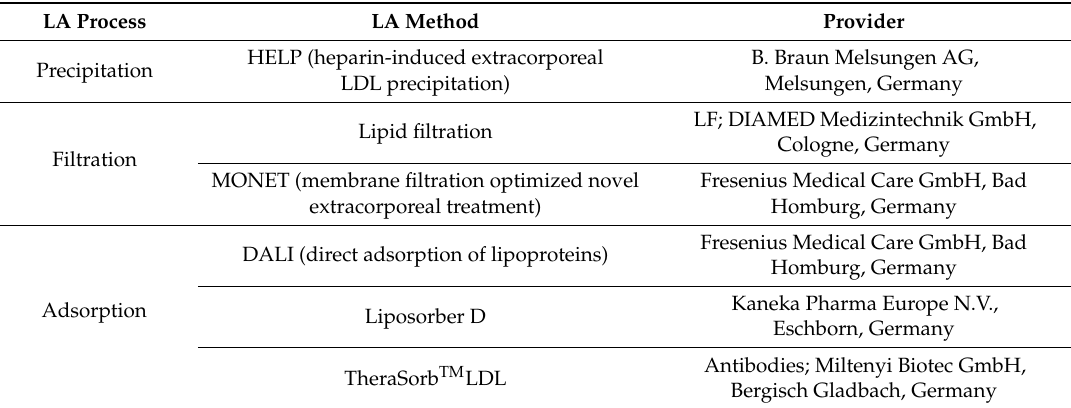
Table 1. LA methods used at our